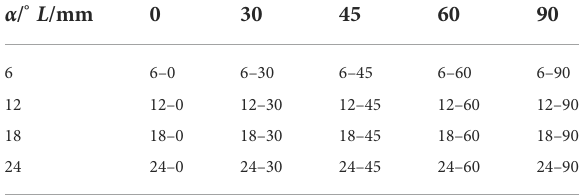
TABLE 3 Test scheme and sample number.